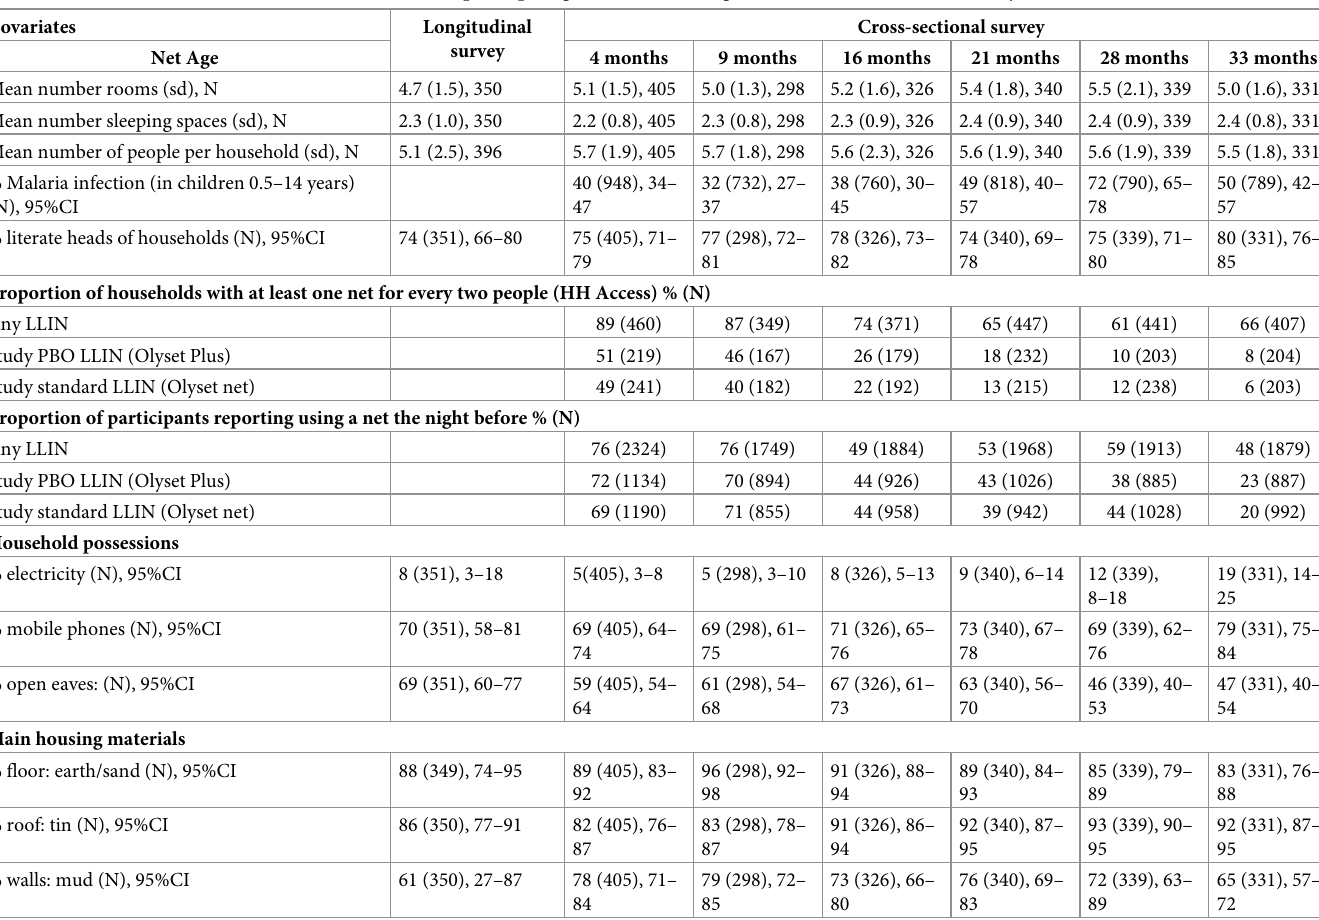
Table 2. Household and socioeconomic characteristics of participating households in longitudinal and cross-sectional surveys. Covariates Longitudinal